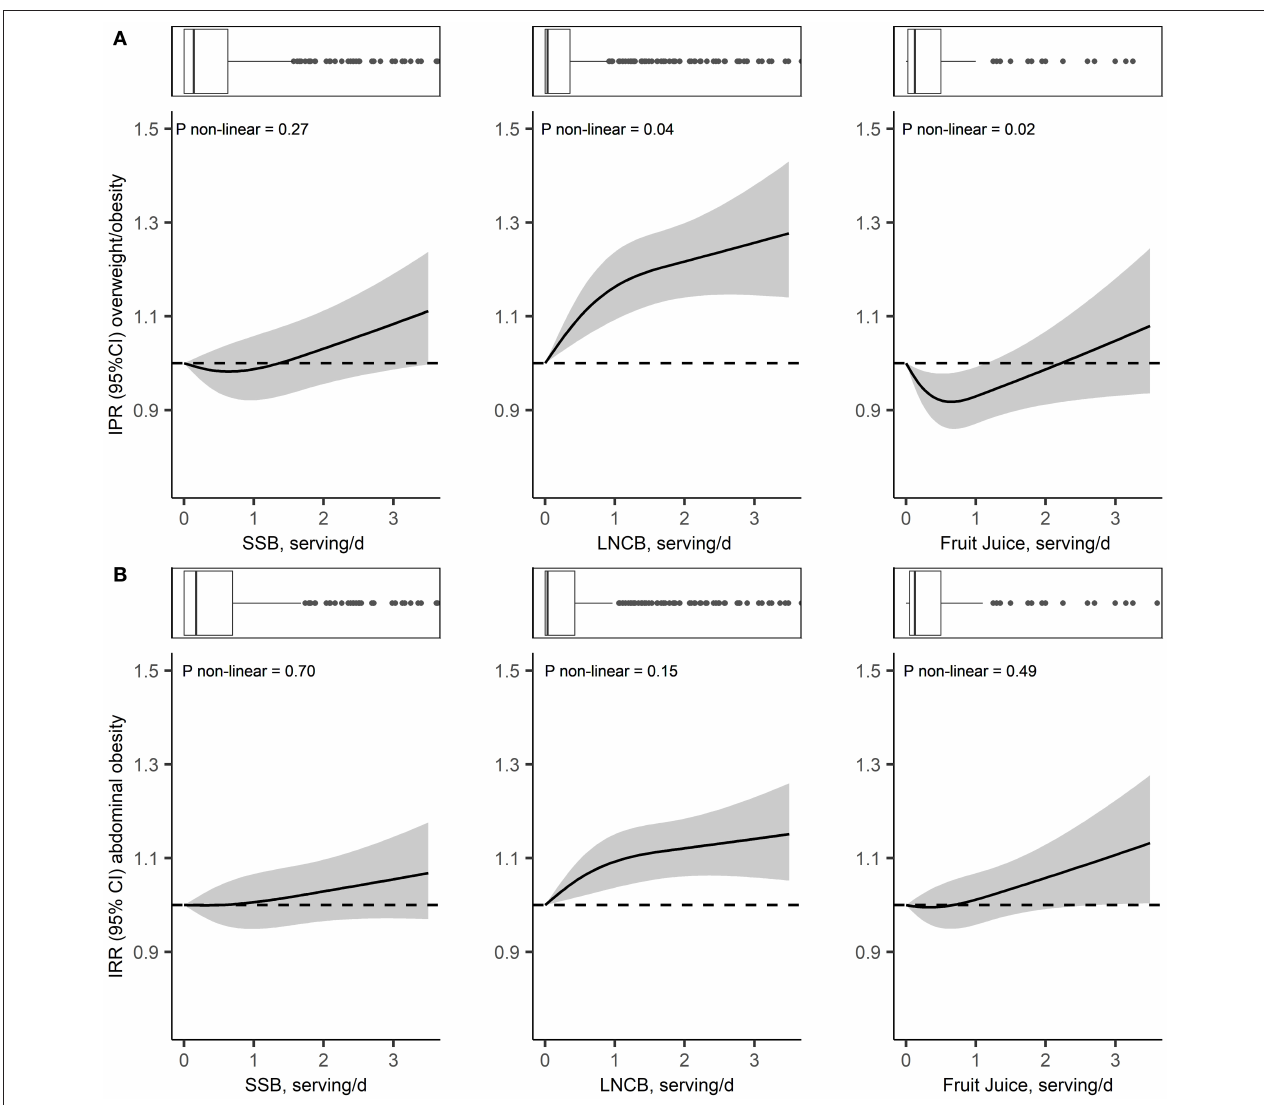
FIGURE 2 | Adjusted dose-response associations of SSB, LNCB, and fruit juice consumption with overweight/obesity incidence (A) and abdominal obesity incidence (B) in participants with normal values at baseline (i.e., < 25 kg/m 2 for overweight/obesity and ≤ 94cm in men and ≤ 80cm in women for abdominal obesity) in the Lifelines Cohort Study; Models were adjusted for age, sex, baseline BMI or baseline waist circumference and height (for models with abdominal obesity as outcome), education, alcohol intake, smoking, physical activity, all dietary factors, total energy intake and history of diseases; SSB, sugar-sweetened beverages; LNCB, low/no-calorie beverage; IPR, incidence proportion